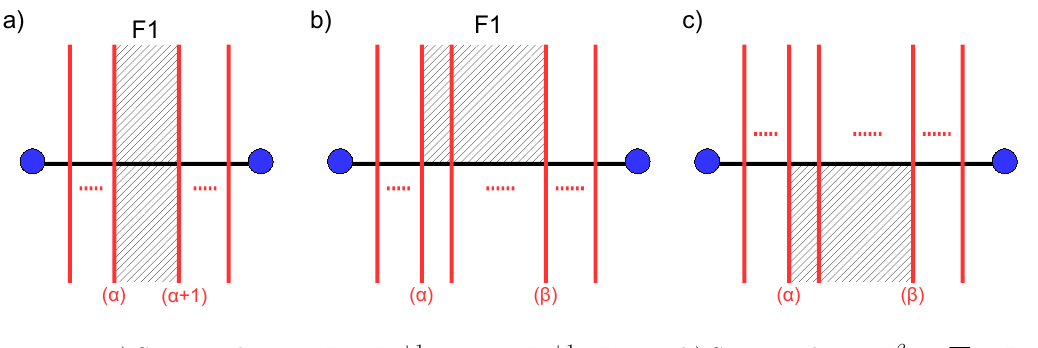
Figure 17 . a) Setup realizing (cid:0) Z (cid:11) (cid:11) Z (cid:11) +1 (cid:11) +1 or (cid:0) Z (cid:11) +1 (cid:11) Z (cid:11) (cid:11) +1 . b) Setup realizing Z (cid:12) (cid:11)